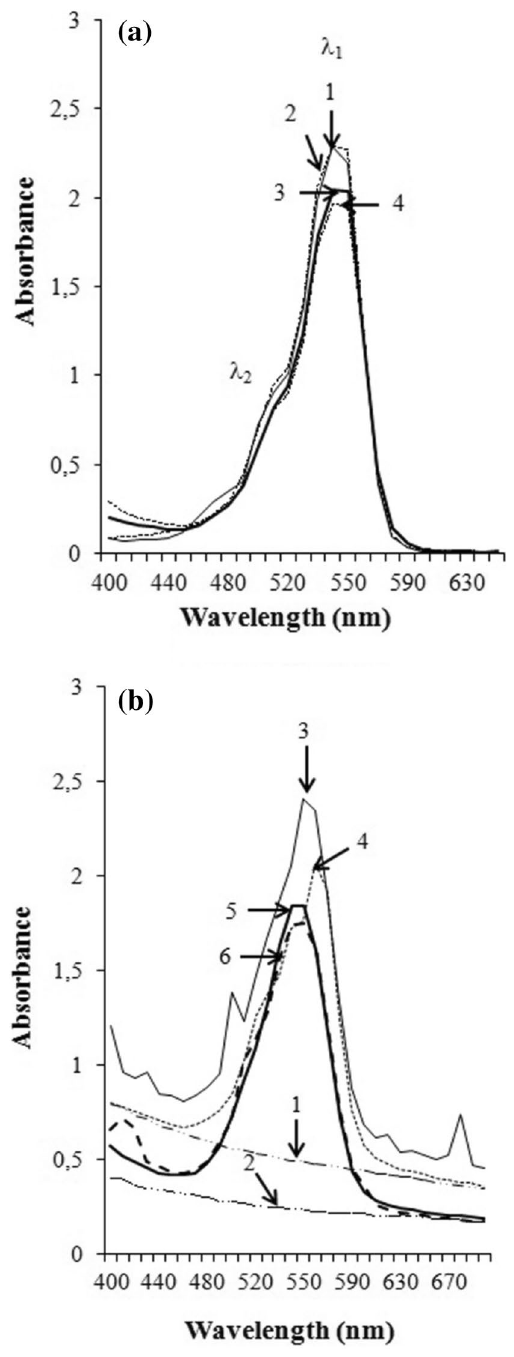
Fig. 2 Effects of S. aureus and Trp on the spectral characteristics of RB. Absorbance curves of RB at the dye concentration of 20 µM: a Without bacteria: (1) in PBS protected from light and (2) after 10 min of visible irradiation time at a light fluence dose of 30 J/cm 2 , (3) in the presence of Trp (10 mM) protected from light and (4) after 10 min of visible irra- diation time. b In the presence of S. aureus at a concentration of 5.1 10 7 CFU ml −1 : (1) absorbance curve of S. aureus protected from light in the absence of RB and antioxidants and (2) after 10 min of visible irradia- tion time, (3) in the presence of RB in PBS before and (4) after 10 min of visible irradiation time, (5) in the presence of RB and Trp before and (6) after 10 min of visible irradiation